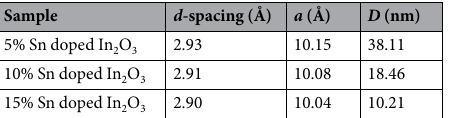
Table 1. d- spacing, lattice parameter a and crystallite size D of Sn doped indium oxide